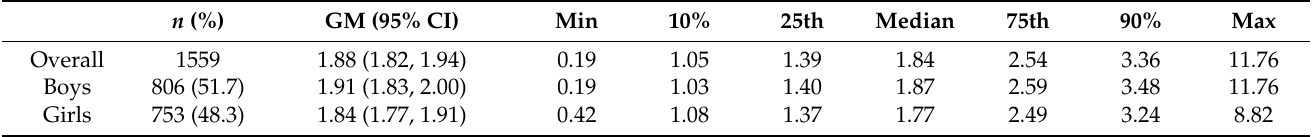
Table 2. Distribution of blood Hg concentration ( µ g/L) according to sex.